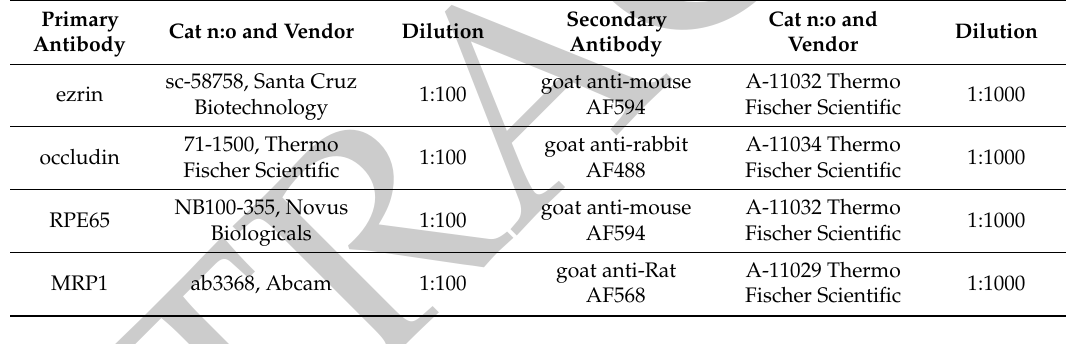
Table 1. The antibody